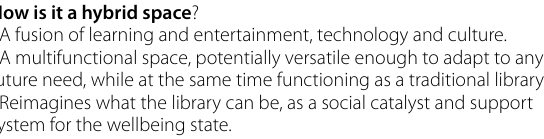
Table 2 Anticipatory analysis of the Oodi